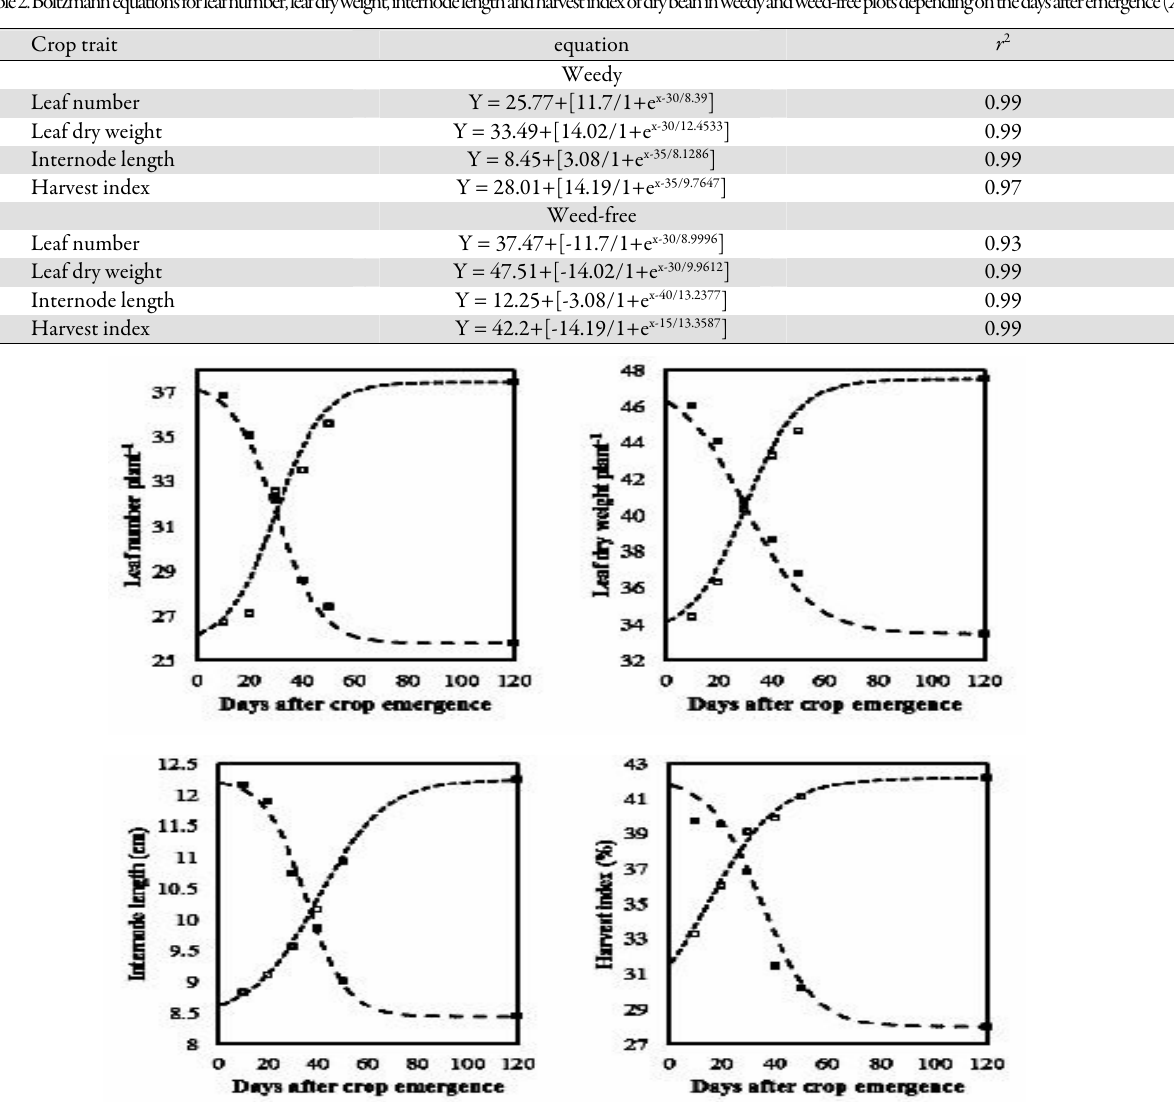
Fig. 3. The effects of duration increase of weed-infested (squares) and weed-free (empty squares) periods on different traits of dry bean using the sigmoid Boltzmann model. Equations for fitted curves are given in Table 2